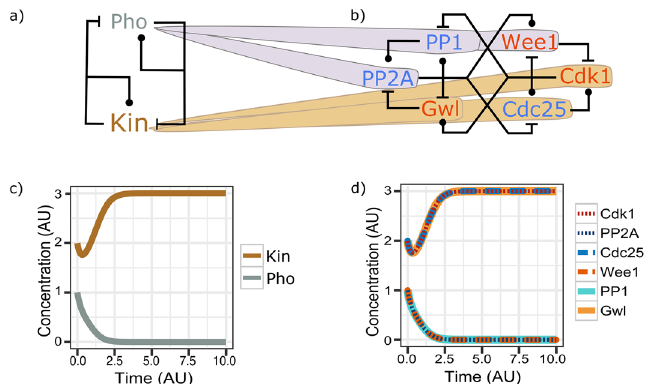
Figure 1. Similar dynamical behaviour of the mitotic entry and the mutual inhibition (MI) systems. ( a ) Wiring diagram of the Mutual Inhibition system (MI system). ( b ) Wiring diagram of the regulatory network of the G2/M transition. Colours of molecular species show their biological type: PP1, PP2 and Cdc25 are phosphatases (blue), and Gwl, Wee1 and Cdk1 are kinases (orange). Edges indicate catalytic reactions: ball-end activation; dash-end inhibition. Both networks are shown as influence networks 36 (Supplementary Figure S1). Shadows